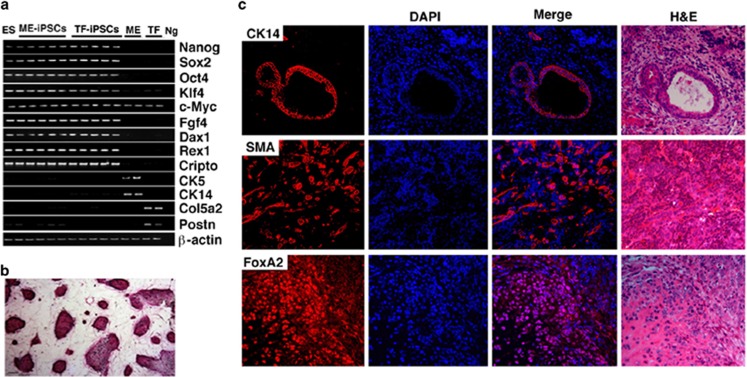
Comparison of growth and differentiation between TF-iPSCs and ME-iPSCs in culture. (a) RT-PCR analysis of gene expression. Five of each independently generated TF-iPSC and ME-iPSC clone at low passages (P7–8) were examined for the expression of ESC markers. ESCs were used as a positive control. Parental ME cells express the epithelial markers CK5 and CK14, and parental TF cells express the fibroblast markers Col5a2 and Postn. (b) Alkaline phosphatase activity was detected in all four iPSC clones, and ESCs was detected by alkaline phosphatase staining. (c) Identification of the cell lineage of three primary germ cell layers in teratomas formed by iPSCs injected into nude mice, as revealed by staining for CK14 (an ectoderm marker), SMA (a mesoderm marker), and FoxA2 (an endoderm marker). Teratomas formed by ME-iPSCs, TF-iPSCs, and ESCs show similar histopathological features, although only those formed by ME-iPSCs are shown